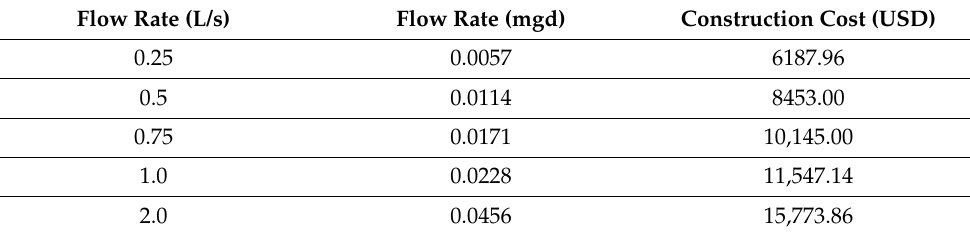
Table 14. Construction cost of a conventional flocculator.